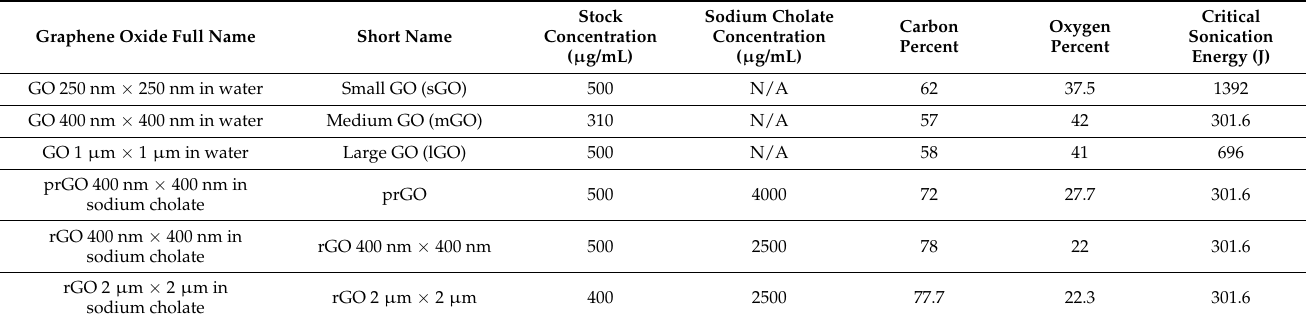
Table 1. GO characterization data. Six GOs were provided by the NHIR Consortium. Three were dispersed in water (GO 250 nm × 250 nm, 400 nm × 400 nm, and 1 µ m × 1 µ m); the remaining three were dispersed in sodium cholate (prGO 400 nm × 400 nm; rGO 400 nm × 400 nm, 2 µ m × 2 µ